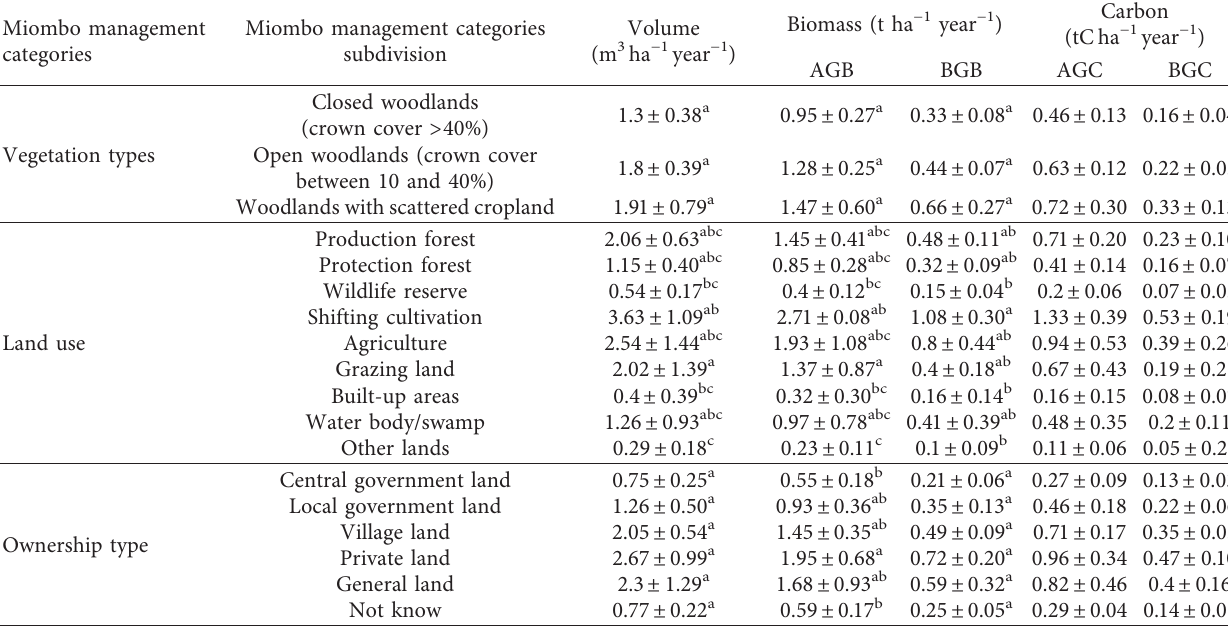
Table 2: Volume, biomass, and carbon removals by vegetation, land use, and ownership types.